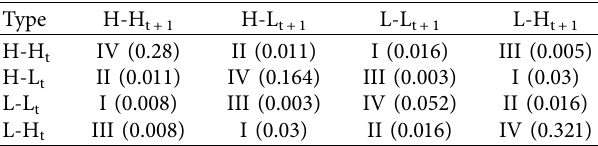
Table 4: Construction industry’s local Moran’s index transition probability